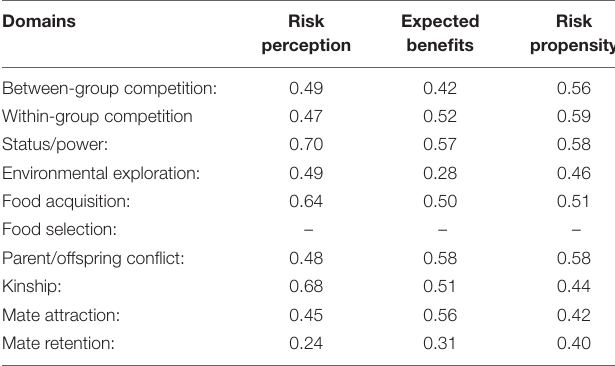
TABLE 2 | Cronbach values for each of the evolutionary domains in the three contexts of the ERS.